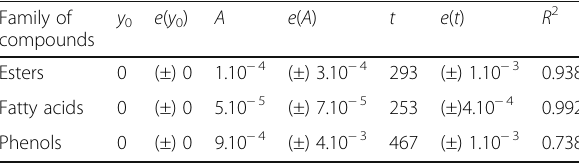
Table 6 Fitting correlation parameters found for the different families of organic